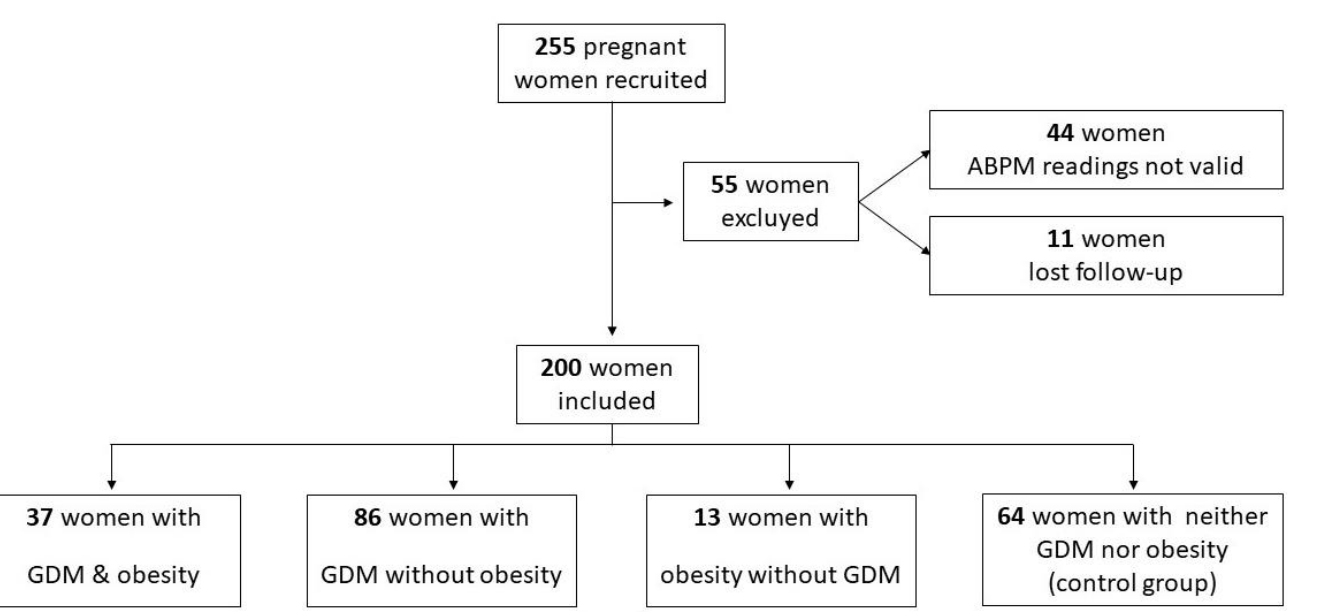
Figure 1. Study flow chart: algorithm for the identification and classification of eligible women. ABPM: ambulatory blood pressure monitoring; and GDM: gestational diabetes mellitus.